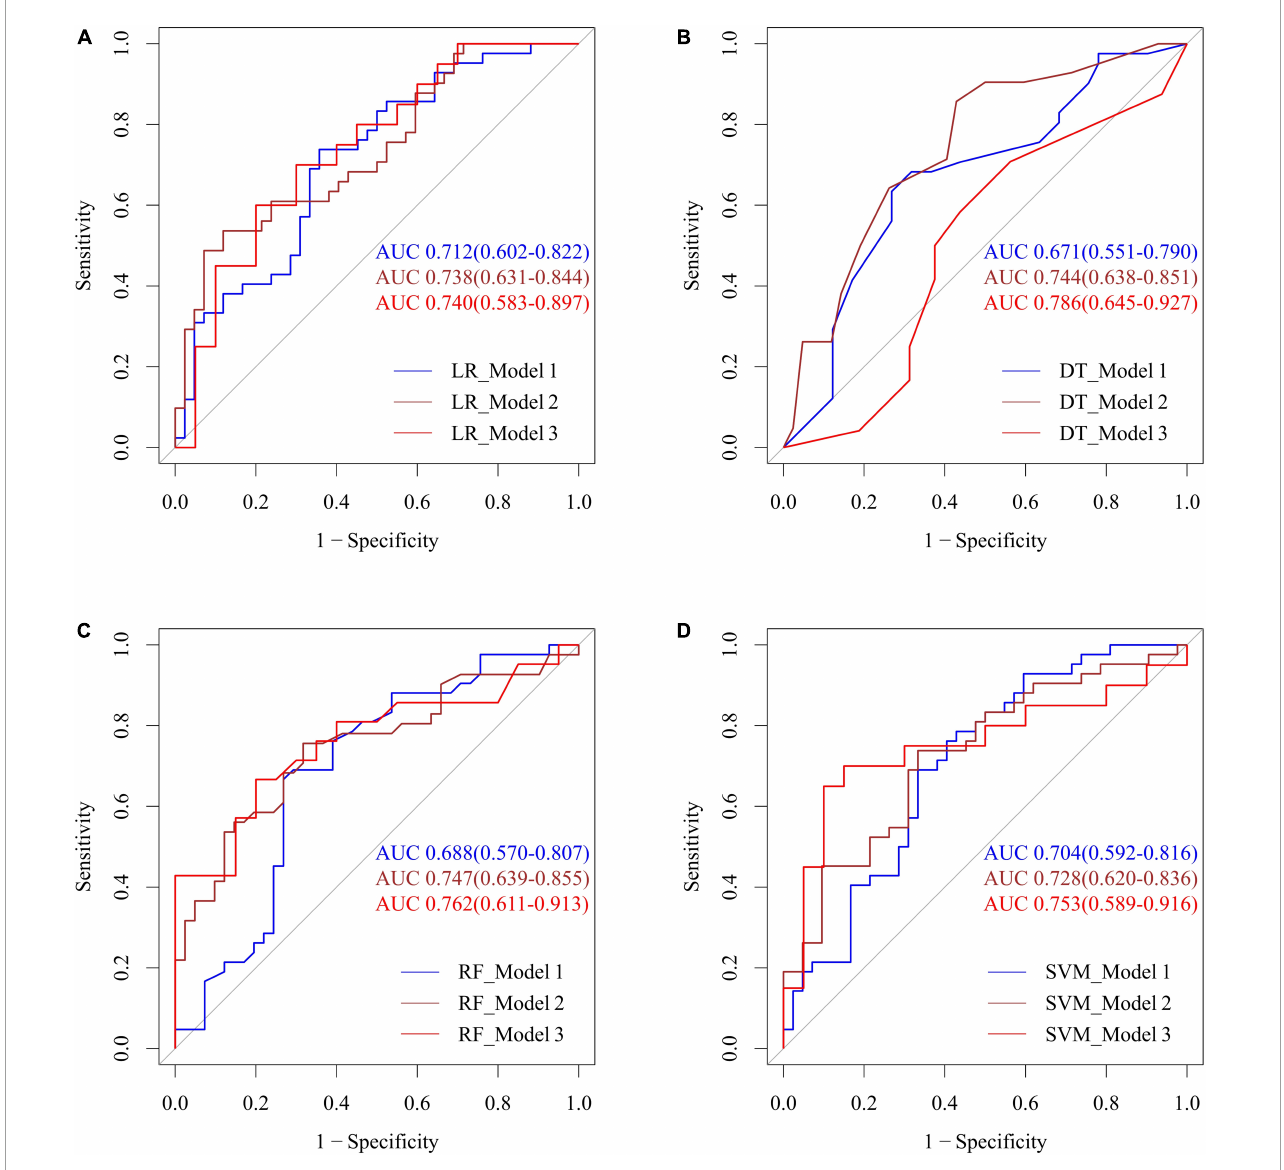
FIGURE6 Performance of four machine learning methods including LR (A) , DT (B) , RF (C) , and SVM (D) with the means of various BP parameters, posterior circulatory artery stenosis score for predicting CI. Model 1: SBP, DBP, pulse; Model 2: model 1 + BMI, previous myocardial infarction history, and previous stroke history; Model 3: model 2 + BA stenosis score, right and left PCA stenosis scores. SBP, systolic blood pressure; DBP, diastolic blood pressure; BMI, body mass index; LR, logistic regression; DT, decision tree; RF, random forest; SVM, support vector